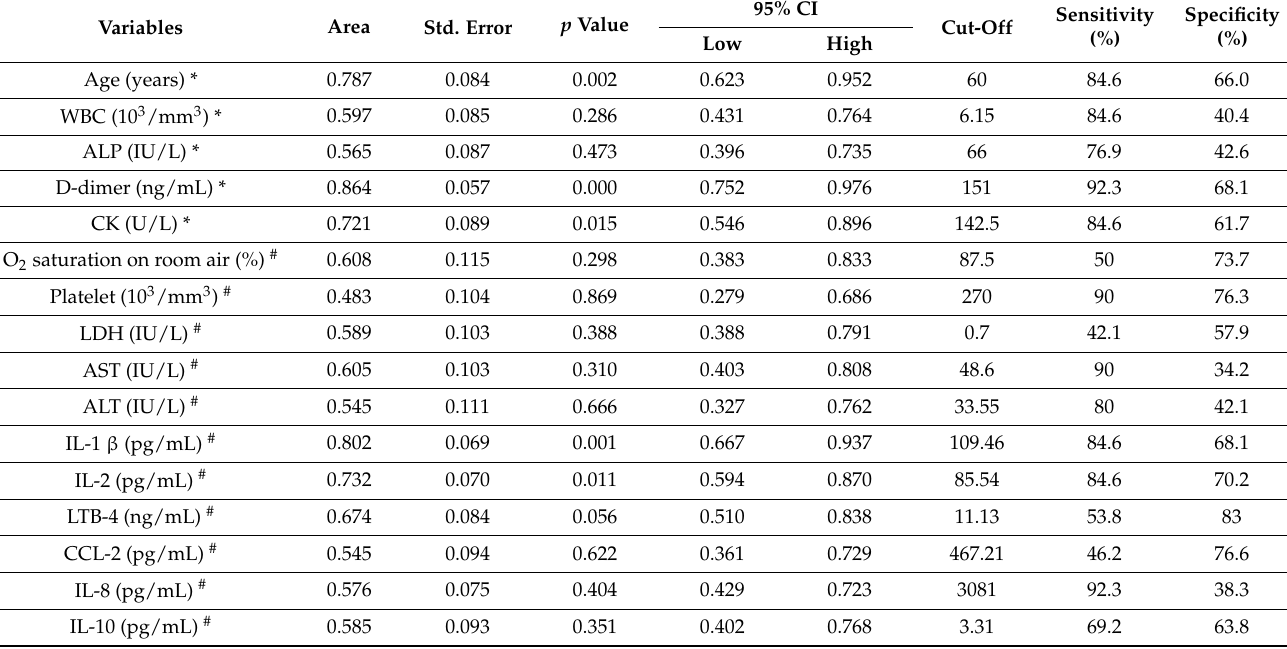
Table 4. ROC curve analysis of possible predictors of